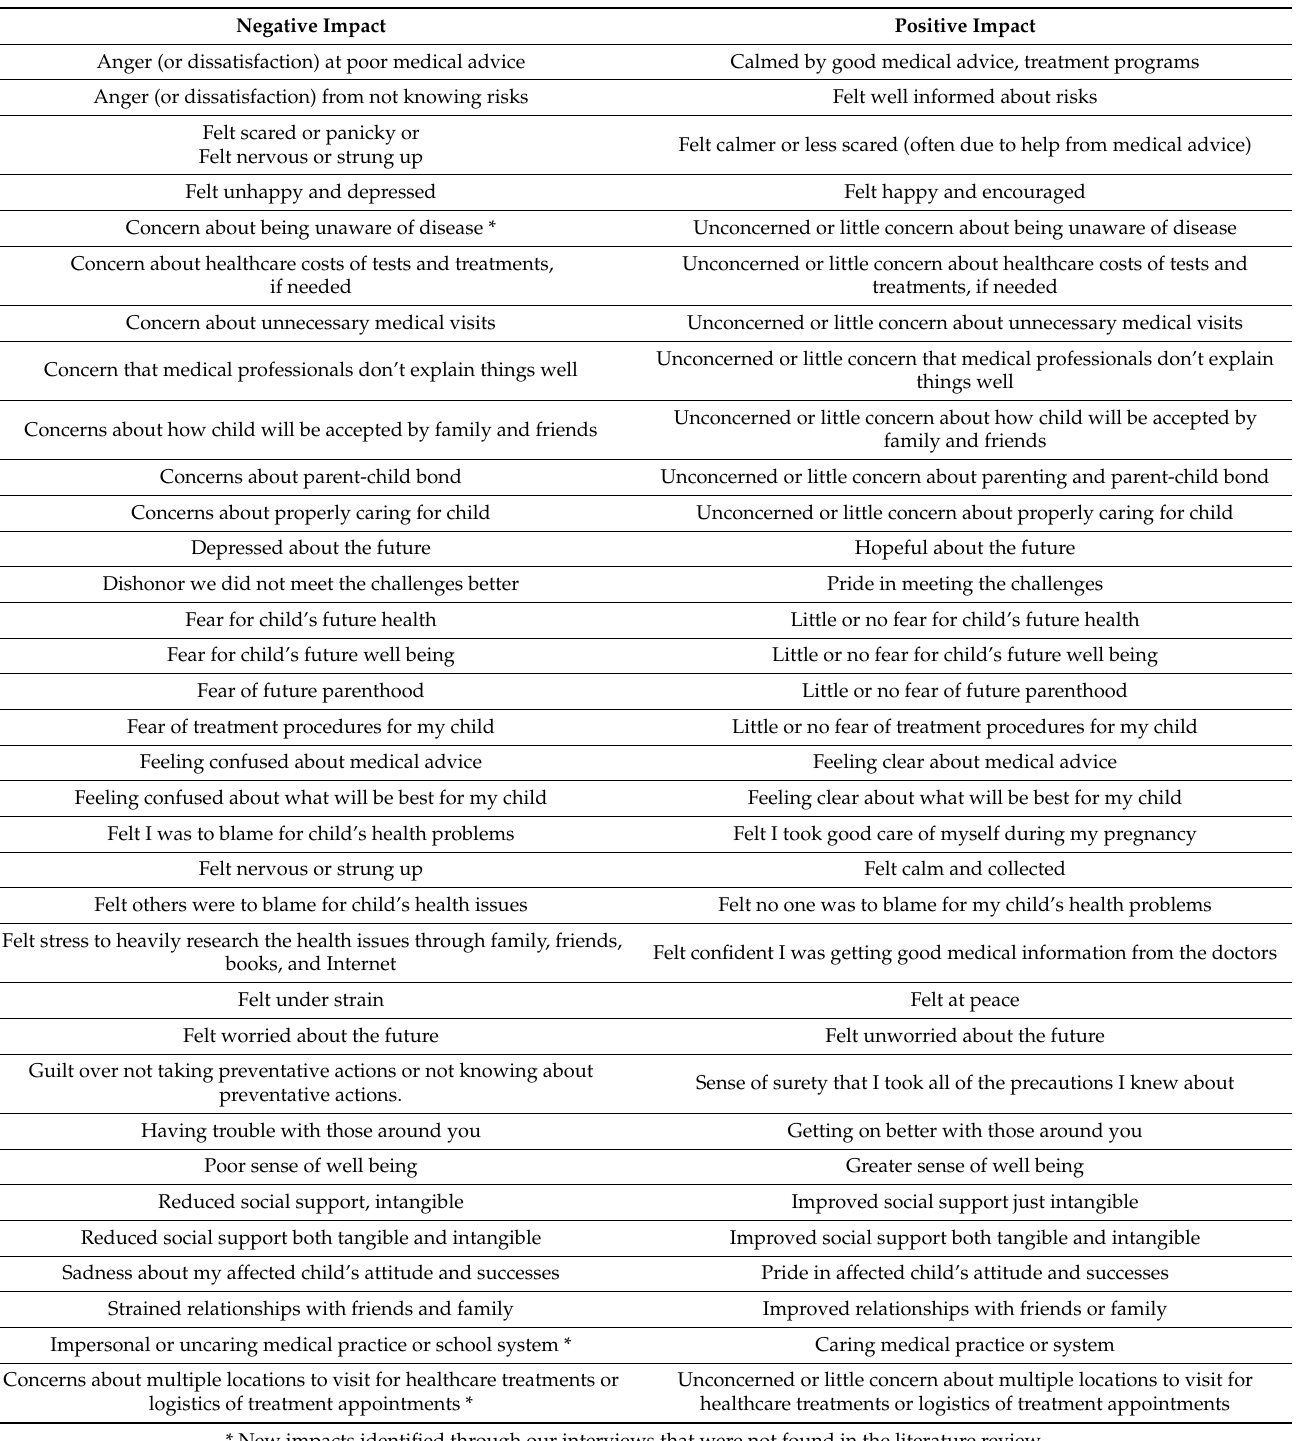
Table 2. Corollaries of Negative and Positive